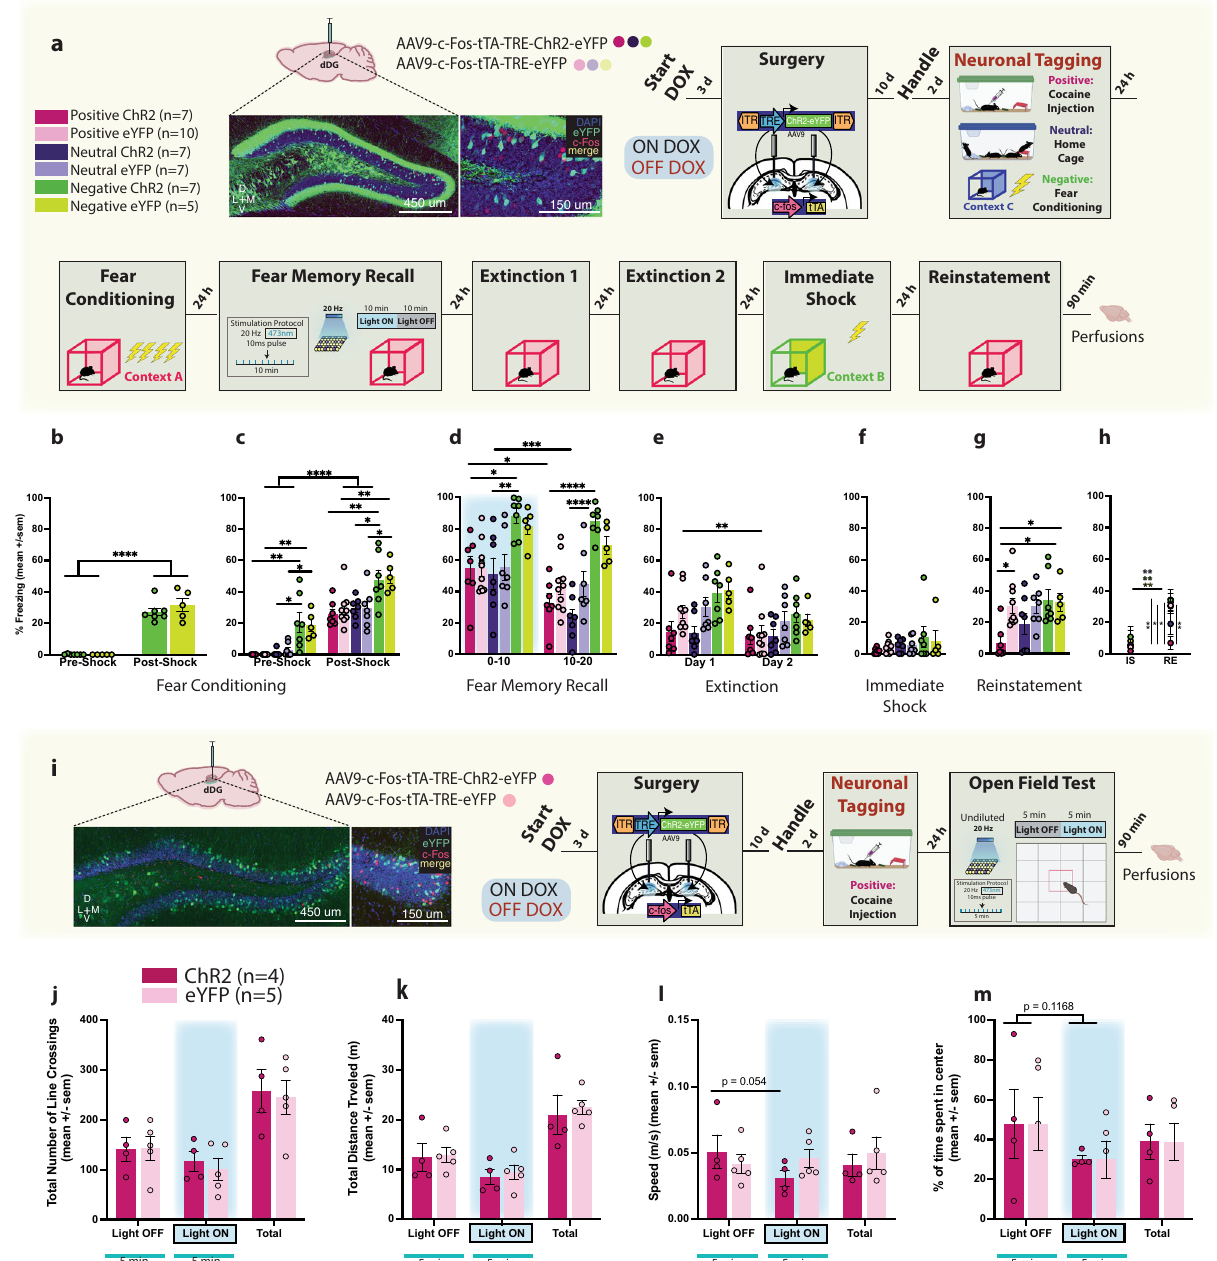
Fig. 2 | Valence matters: Arti fi cial reactivation of a neutral home cage experi- ence during reconsolidation is not suf fi cient to disrupt a fear memory. a Viral strategy and experimental design. dDG cells encoding positive, neutral, and negatively-valenced behavioral epochs were tagged off-DOX (orange). b Negative groups were initially FC in an alternate context (Context C). These mice showed greaterfreezing post-shock(two-wayRMANOVA:F(1,10)= 168.4, P < 0.0001). c The next day all mice were FC. While all mice showed increased freezing post-shock (three-way RM ANOVA: F(1,37)= 295, P <0.0001), mice in the negative groups demonstrated higher freezing pre-shock (Negative: vs. Positive P < 0.0001, vs. Neutral P <0.0001) (two way RM ANOVA: F(2,40) =27.55, P < 0.0001), and post-shock (three-way RM ANOVA: F(2,37)= 25.25, P <0.0001). d During recall, negative groups continued to exhibit increased freezing (three-way RM ANOVA: F(2,37)= 3.286, P < 0.0486, Valence × Virus × Time). Negative-ChR2 mice froze more than neutral-ChR2 mice in the fi rst ( P = 0.0086) and last 10min ( P < 0.0001) and more than positive-ChR2 mice at both time points ( P = 0.255, P <0.0001). Positive ( P = 0.0072) and neutral ( P = 0.0002) ChR2 mice showed faster decline in